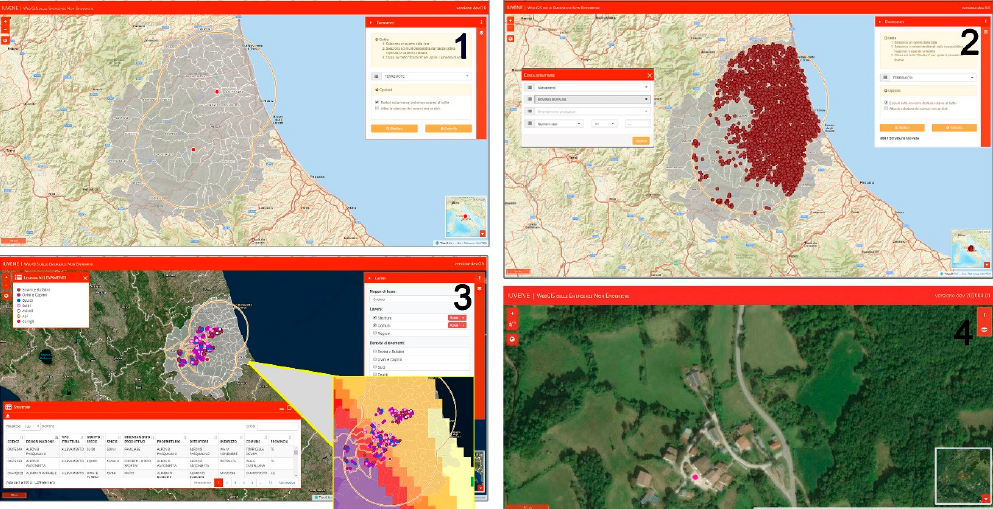
Figure 6. Web GIS application workflow: ( 1 ) Identification of municipalities involved in the emergency area. The map shows the earthquake epicenters (red dots) and the administrative units involved (selected by user through the “search” toolbox, in the upper right, listing all emergency events stored in the system) in the emergency area of interest. ( 2 ) The “exposed elements” (livestock farms) falling in the emergency area can be identified and showed on the map as dots of different colors using the “data filter” tab based on a predetermined list of different types of structures, animal species, and type of productions (meat, eggs, milk, and wool). ( 3 ) The “data filter” tab allows the user to refine the search for holdings selected according to specific criteria (e.g., number of animals> 100), and a set of related data is shown on the map. The legend (per the holding layer) at the top left helps reading the map; the dots are colored according to the species; and the “table” tab at the bottom right, showing the information related to each farm (i.e., address, owner, species, number of animals, production type, etc.), is exportable as an excel file. The farms insisting on a specific risk level can be easily displayed by selecting the seismic hazard layer on the tab panel at the top right. ( 4 ) A zoomed farm (fuchsia dot) on the satellite map also allows the user to easily visualize details of the farm position and accessibility.